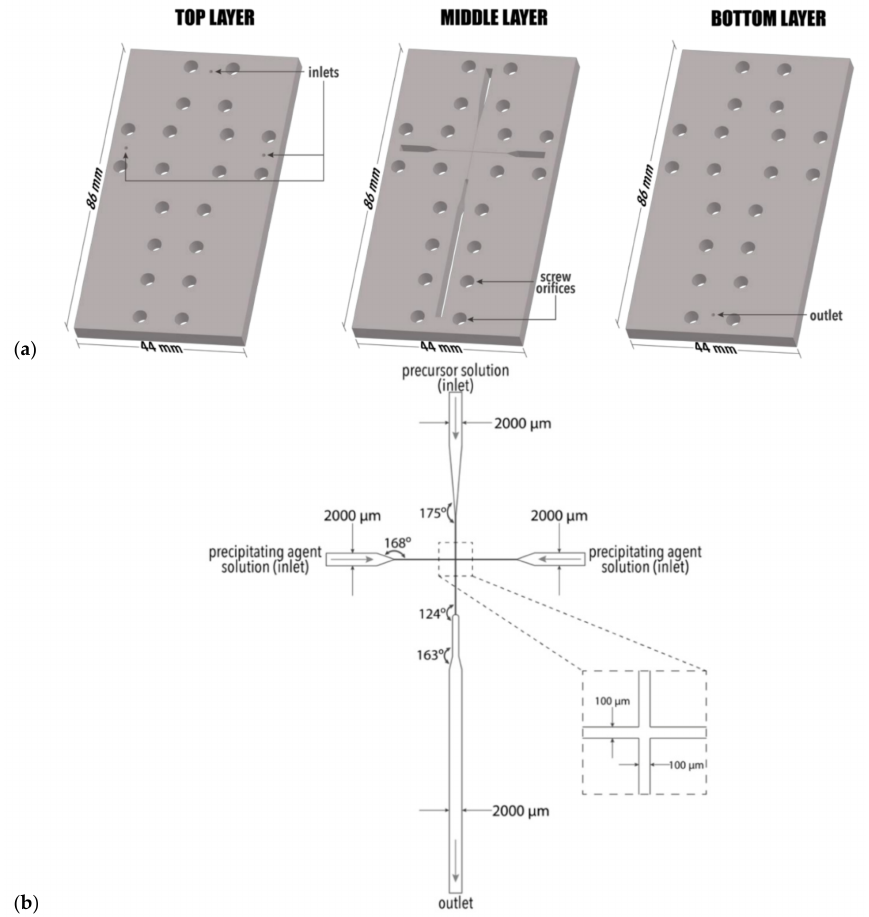
Figure 8. ( a ) Configuration of the three layers comprising the microfluidic device and ( b ) Configu- ration of the cross-junction channel within the middle layer of the device utilized by Chircov et al. Reprinted from an open-access source